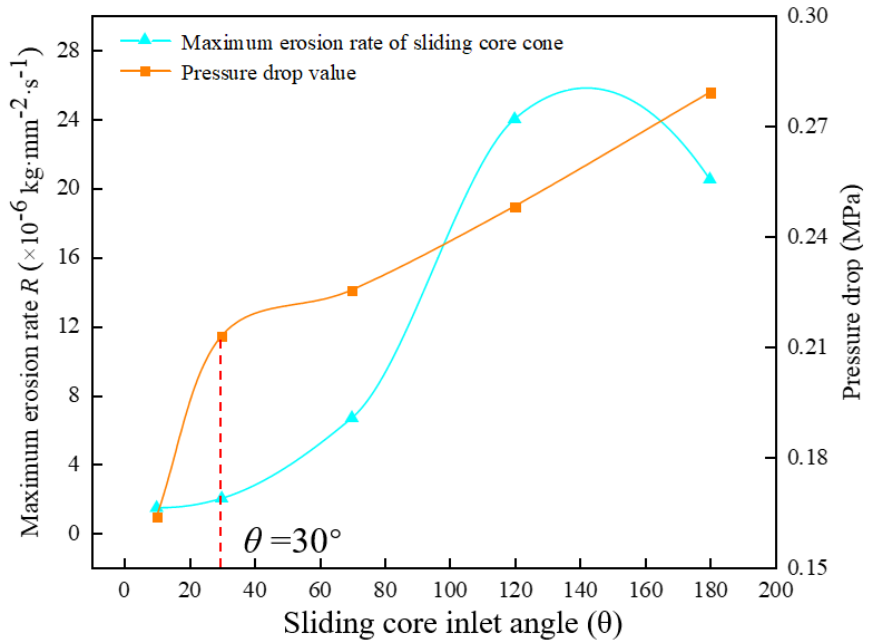
Figure 11. Maximum erosion rate and pressure drop of the sliding core cone change with θ value.